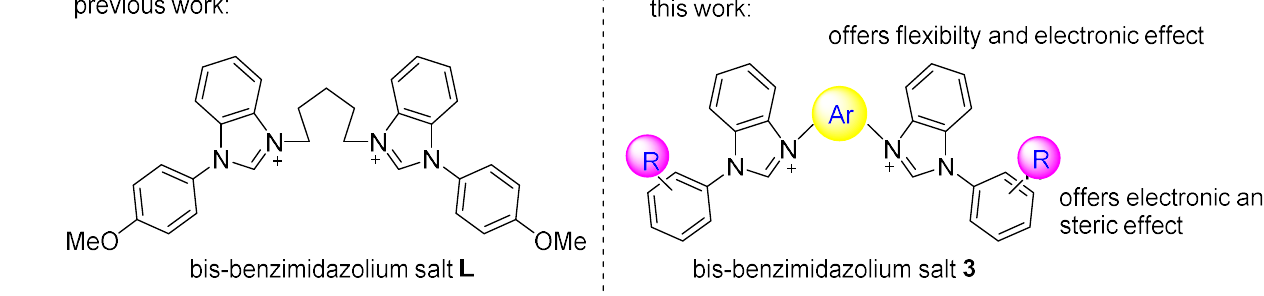
Figure 1. The structures of the new xylyl-linked bis-benzimidazolium salts 3 .